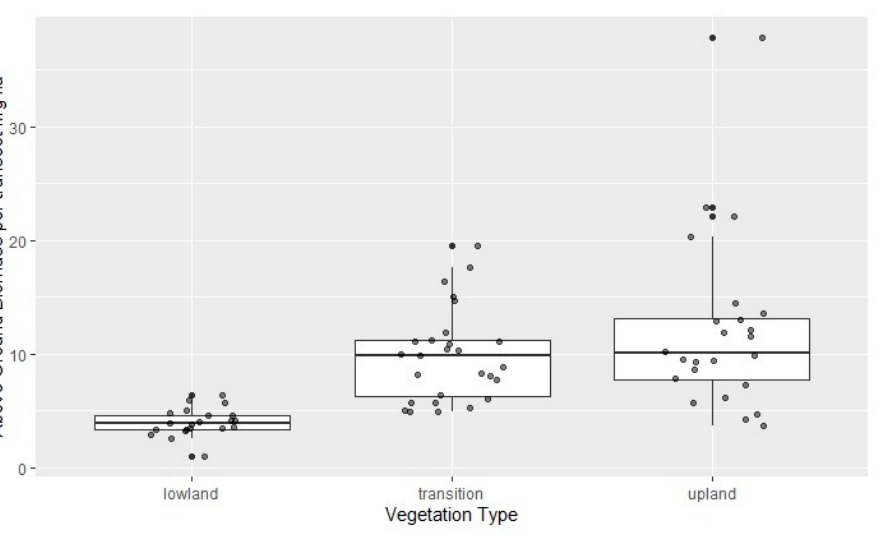
Figure 5. Aboveground biomass for 73 transects (500 m 2 ) per vegetation type. Table 1. Aboveground biomass (AGB), aboveground carbon (AGC), and basal area (BA) at transects in Yaxnohcah, Campeche,